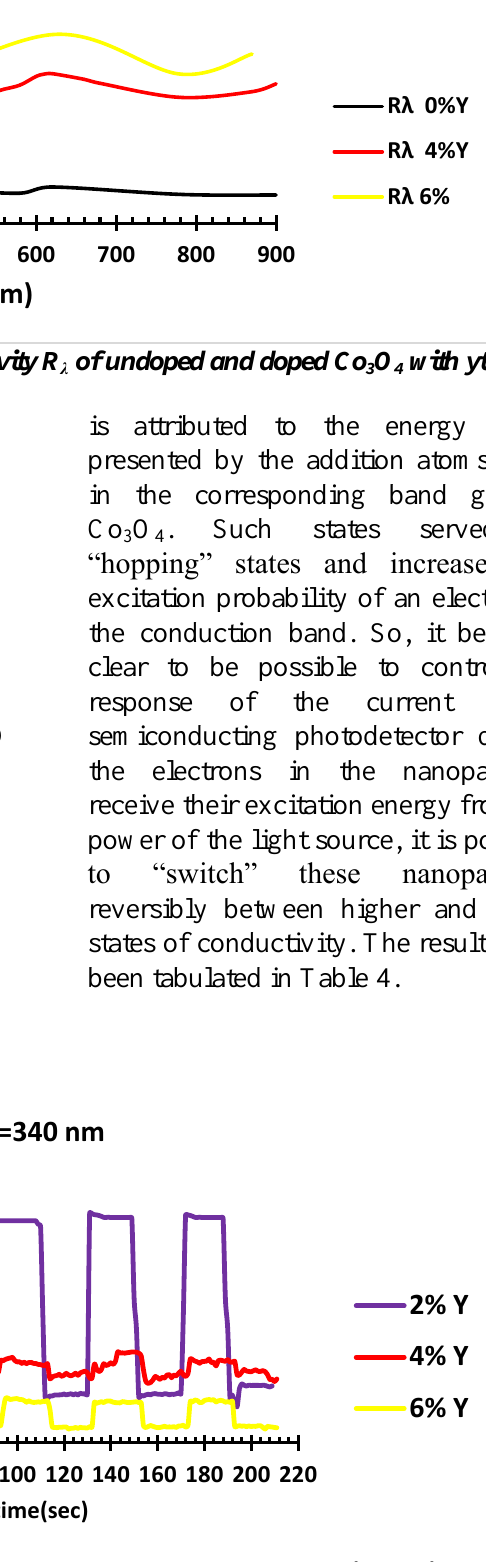
Fig. 5: The variation of spectral responsivity R